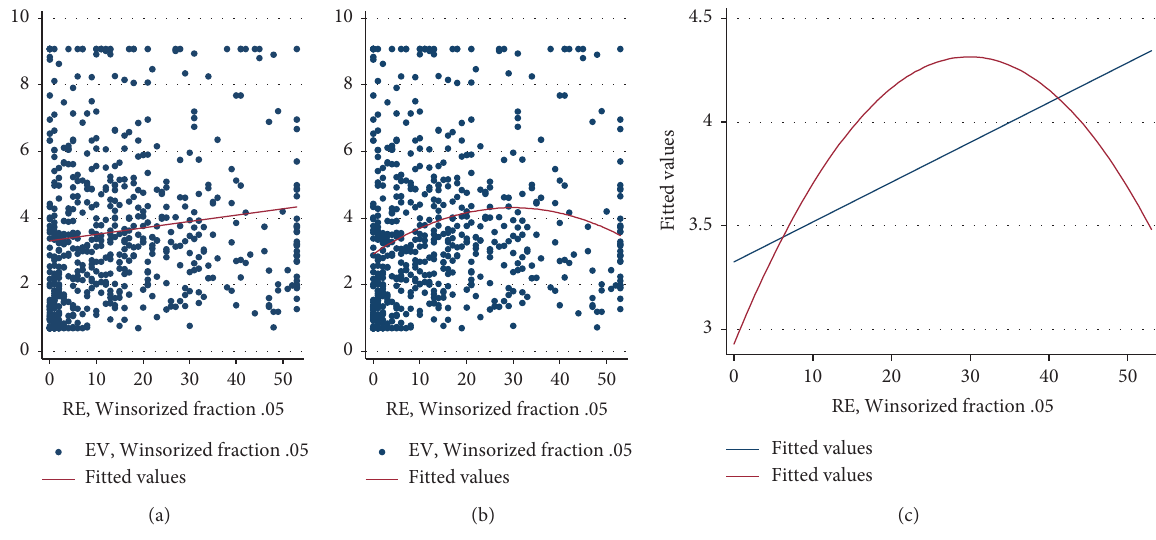
Figure 2: Scatter diagram. (a) Linear fitting. (b) Quadratic fitting. (c) Combination chart. Table 4: The influence of relational embeddedness on enterprise